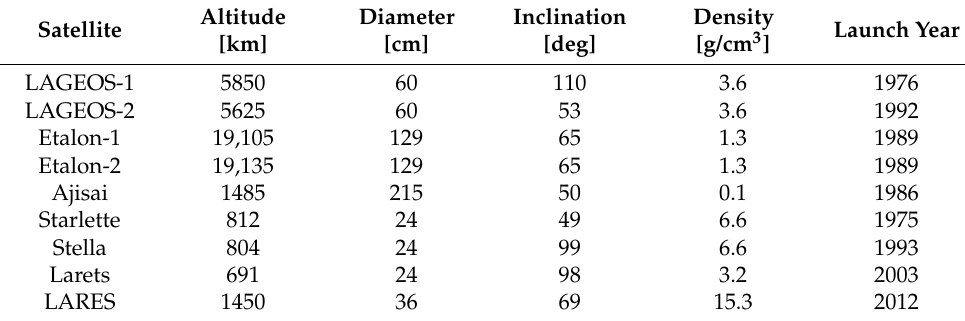
Table 1. Satellite Laser Ranging (SLR) geodetic satellites.